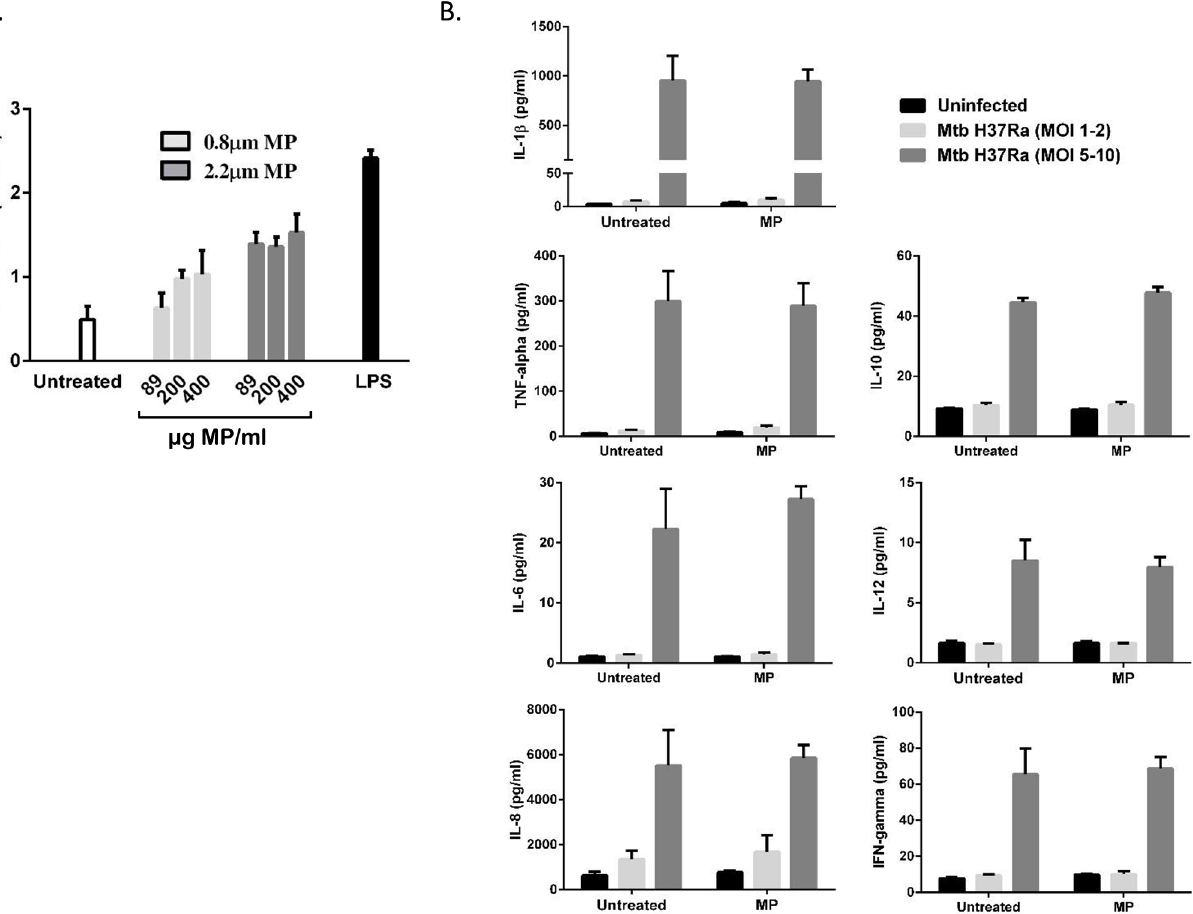
Fig 3. PLGA MPs activate NFkB but do not stimulate pro-inflammatory cytokine secretion by macrophages. (A) THP-1 XBlue ™ cells were differentiated with PMA for 72h and the medium was changed for several days before treatment. Cells were then treated with 0.8 μ m or 2.2 μ m PLGA MPs at the indicated concentrations for 1 hour. Extracellular MPs were washed off and the cells were incubated at 37°C for a total of 24 hours. Supernatants were analysed for the presence of SEAP by means of a substrate reaction and the absorbance was measured at 650nm on a microplate plate reader to determine NFkB activation. Results shown are means +/1 SEM for three independent experiments. LPS (100ng/ml) treatment was used as a positive control for NF κ B activation. (B) THP-1 cells were incubated with media alone (media) or infected with Mtb H37Ra for 3 hours. The cells were then washed to remove extracellular mycobacteria and were treated for 1 hour with 200 μ g/ml MPs. After washing to remove extracellular MPs the cells were cultured for a total of 24 hours after which supernatants were assayed for cytokine levels using MSD multiplex assays. Cytokine levels are reported as mean +/- SEM and are representative of three independent experiments performed in triplicate, * p < 0.05 compared to untreated control.